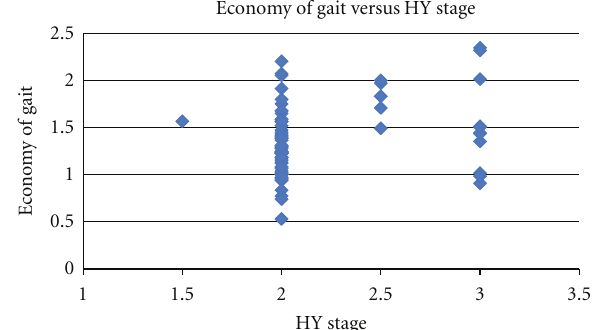
Figure 2: Relationship between the Hoehn and Yahr stage and economy of gait (ratio of measured VO 2 to predicted VO 2 ). Higher values of the ratio of measured VO 2 to predicted VO 2 are indicative of impaired economy of gait.